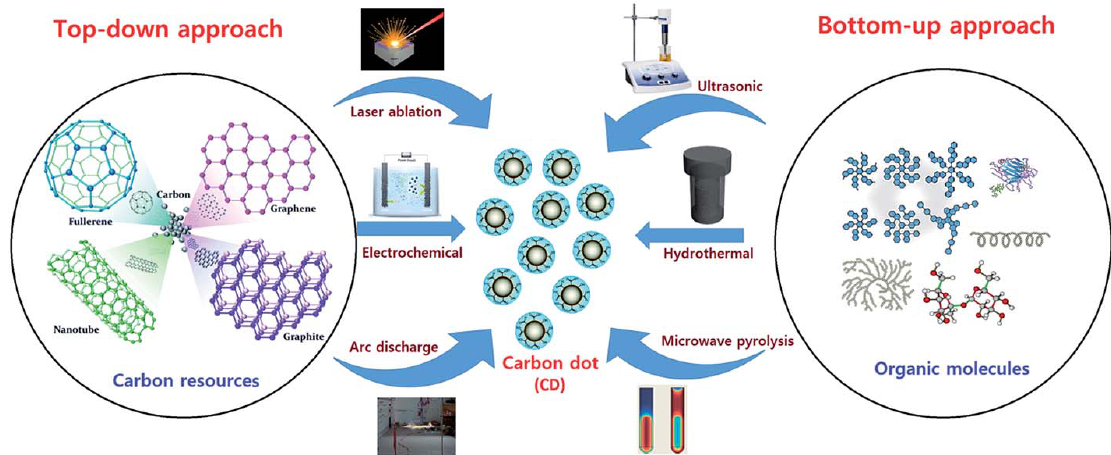
Figure 2. Representation of the possible synthesis methods to prepare carbon dots. Reproduced with permission from [52]. Copyright Royal Society of Chemistry,